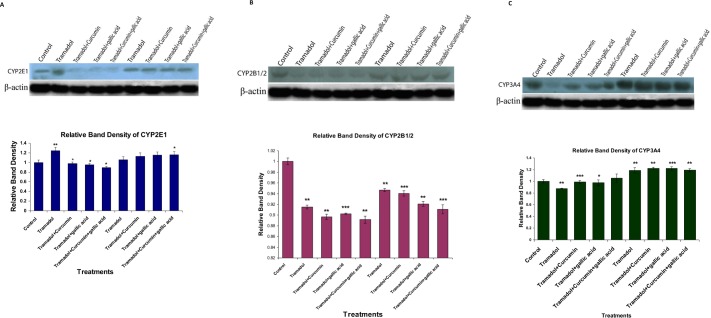
Western blotting data showed changed in protein expression of CYP 2E1, Cyp2B1/2, and CYP 3A4.In all Fig 1A, 1B and 1C), Lane 1 represents the microsomal proteins of matched control group. Followed by represented pooled protein samples of repeated dose treatments of rats with tramadol (lane 2), tramadol+ Curcumin (lane 3), tramadol+ Gallic acid (lane 4), tramadol + Curcumin+ Gallic acid (lane 5) respectively. The last four lanes on the right hand represented the pooled protein samples of single dose treatment of rats with tramadol, tramadol + Curcumin, tramadol + Gallic acid, tramadol + Curcumin+ Gallic acid respectively. The probability values P<0.05; P <0.01; P<0.001 represented by one, two and three stars respectively are significantly different from those of the control groups.